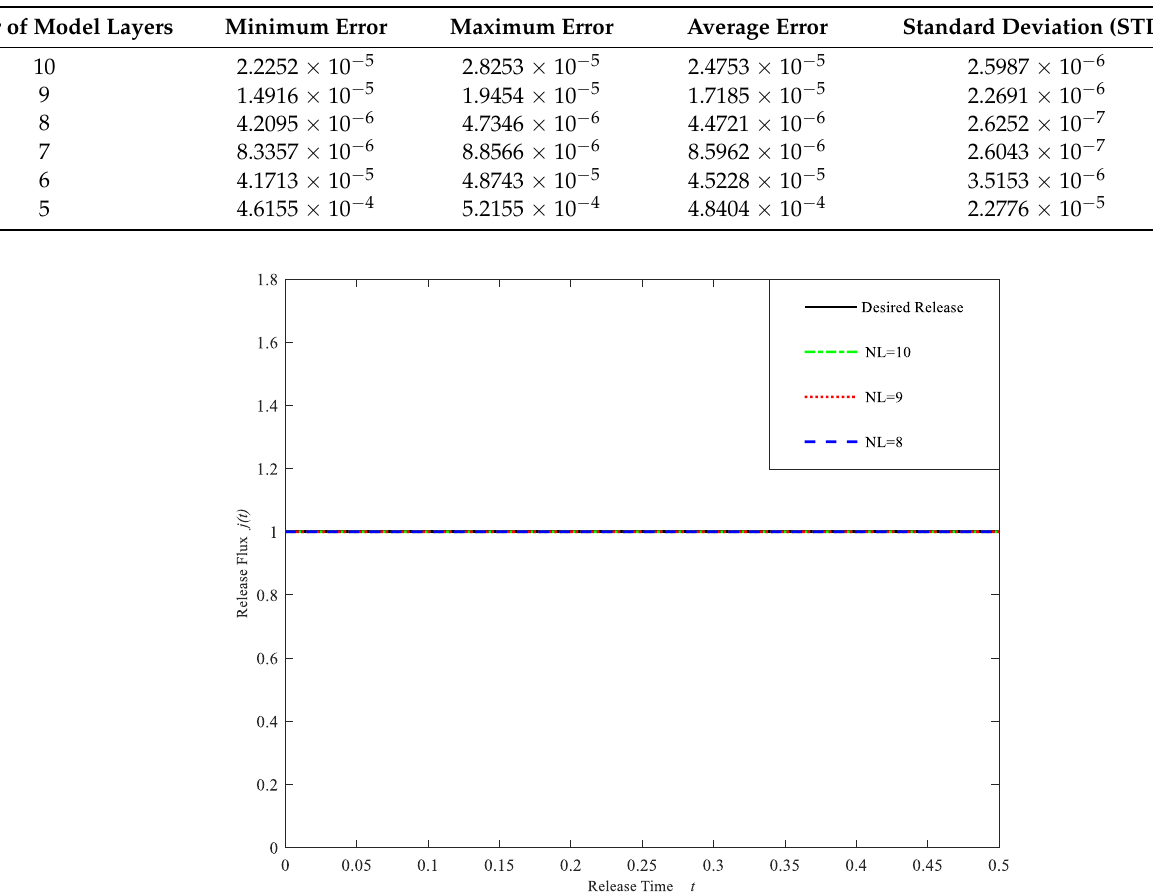
Figure 7. Drug Release profiles for different layers NL = 8, 9, 10 (Case